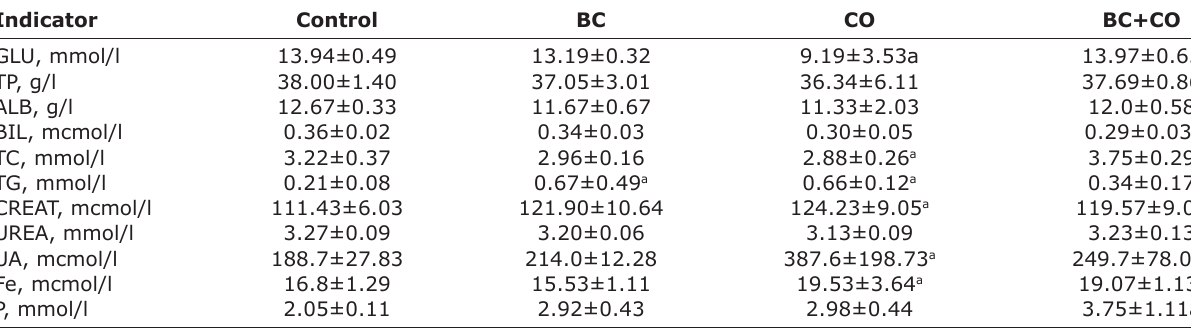
Table-4: Biochemical blood parameters with Bacillus cereus and coumarin in diets (day 42). Indicator